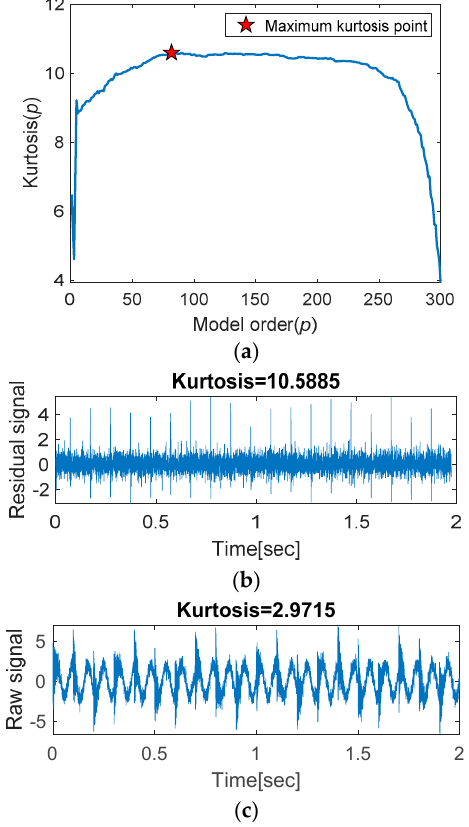
Figure 7. Kurtosis variation in terms of model order and corresponding signals: ( a ) model order selection based on maximum kurtosis, ( b ) residual signal for p = 82, and ( c ) raw signal.